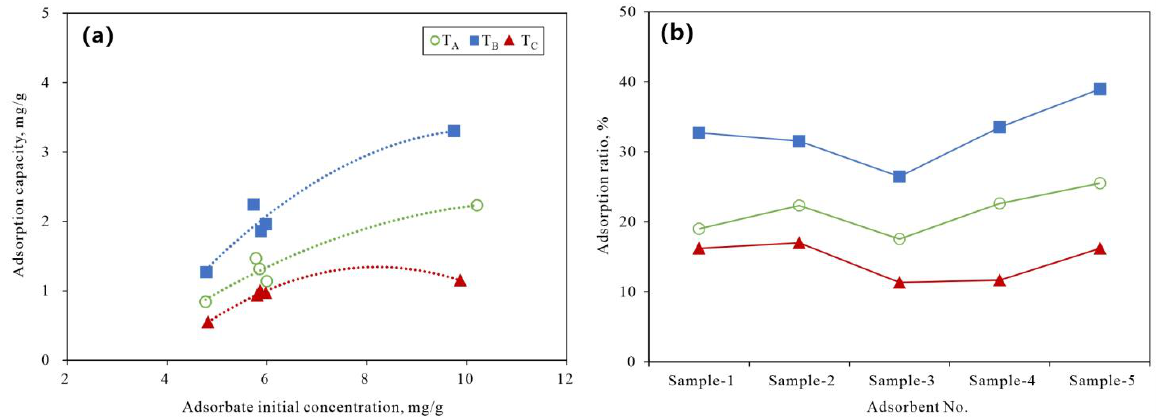
Figure 4. Adsorbate content with adsorption capacity ( a ), and adsorbents with adsorption ratio ( b